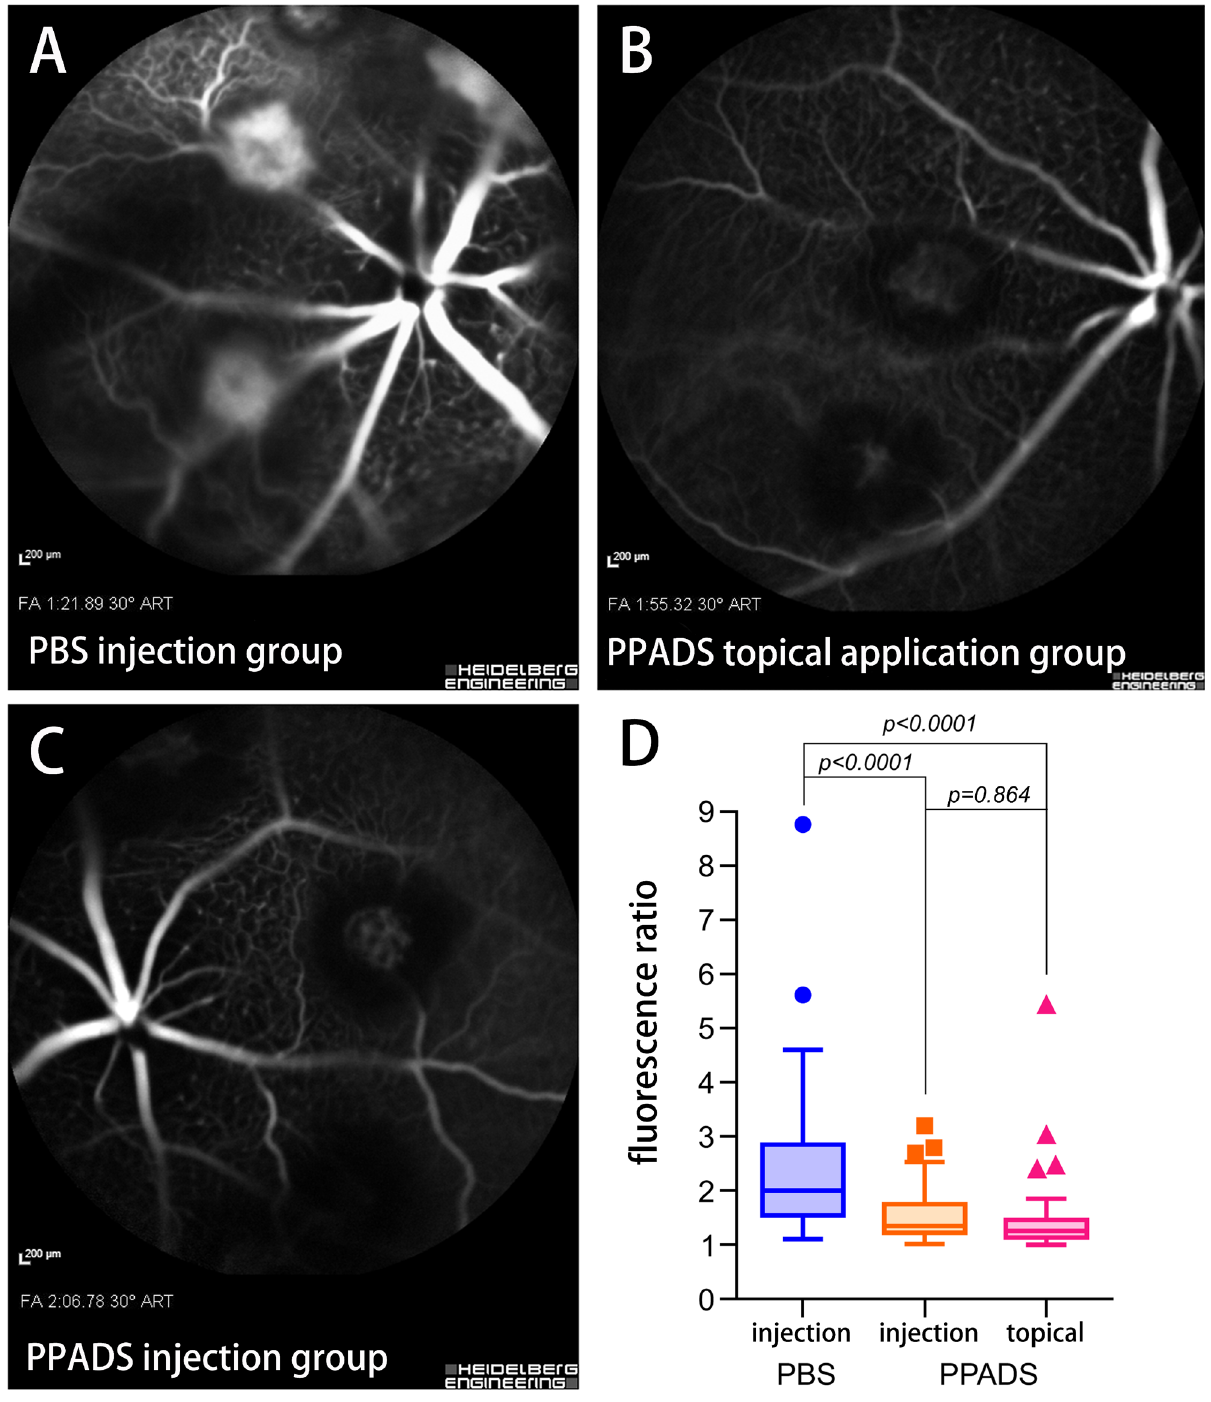
Figure 5. Representative fluorescein angiographs from the three experimental groups ( A PBS injection group; B PPADS topical application group; C PPADS injection group) taken with the scanning laser ophthalmoscope. Diagram (D) shows results of numerical evaluation of intensity of fluorescence in the laser spots showing size of